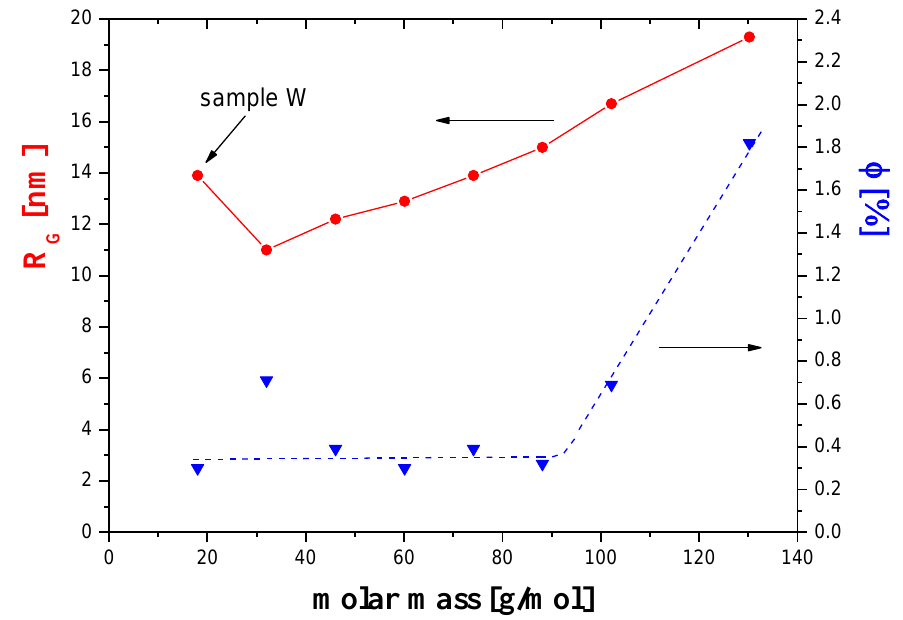
Figure 6. The radius of gyration ( R G ) and the volume fraction of pores ( Φ ) as a function of the coagulant molar mass.